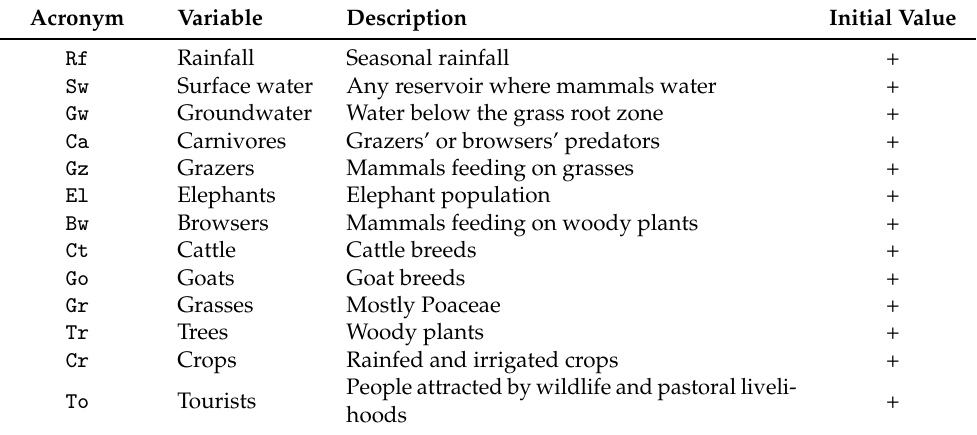
Table 2. Variables and their initial